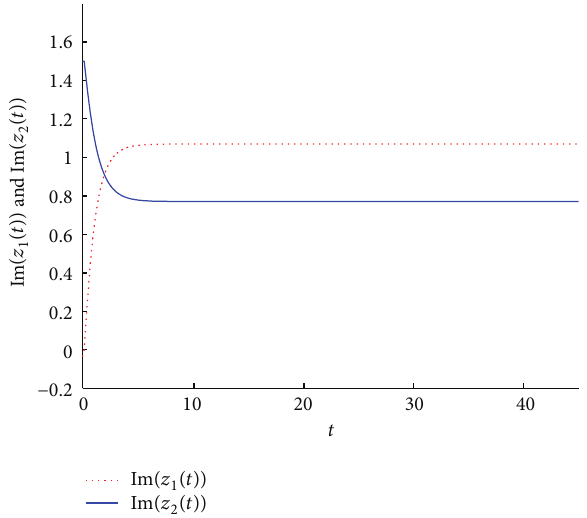
Figure 2: State trajectories of neural network (38).